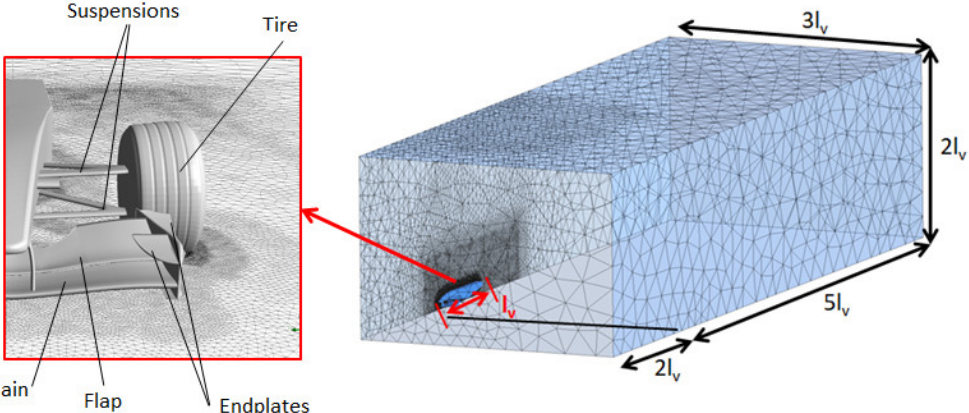
Figure 2. Computational domain and geometry detail of the vehicle simulated.